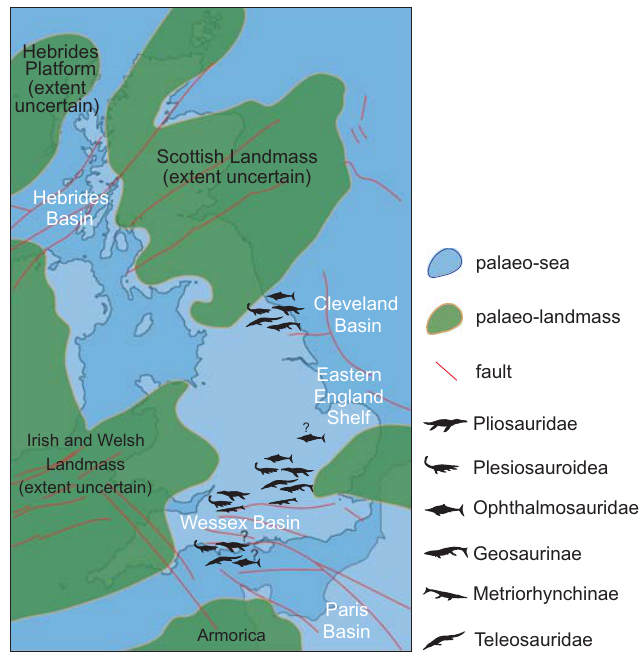
Fig. 1. Palaeogeographical map of Mid-Oxfordian in the UK (from Bradshaw et al. 1992 and Coe